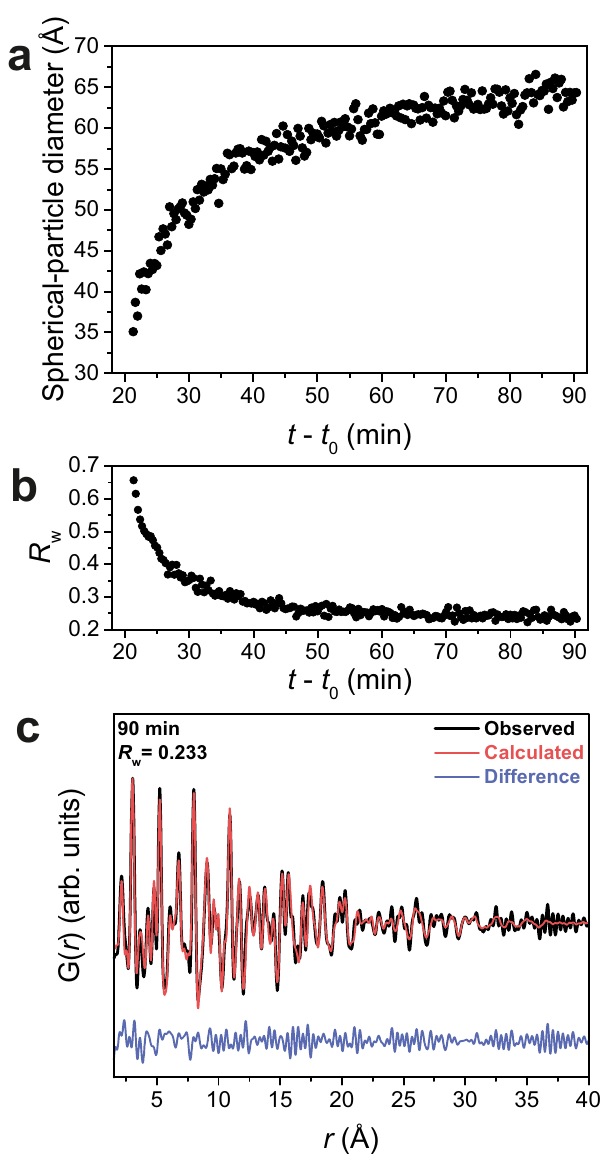
Fig. 5 Results of the sequential PDF re fi nement. a Evolution of sp diameter as a function of the reaction time. b Fit-quality R w progression as a function of the reaction time. The data in a and b were obtained from the sequential re fi nement of time-resolved PDFs. c Experimental and calculated PDFs G( r ) for the reaction at 160 °C after 90 min. The calculation imposes a rock-salt CoO phase 75